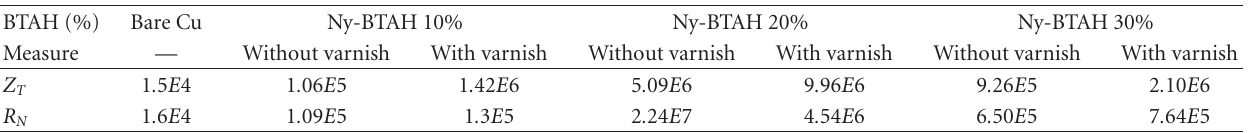
Table 1: Electrochemical impedance modulus and noise resistance as a function of BTAH concentration for electrospun nylon alkyd varnish coating.